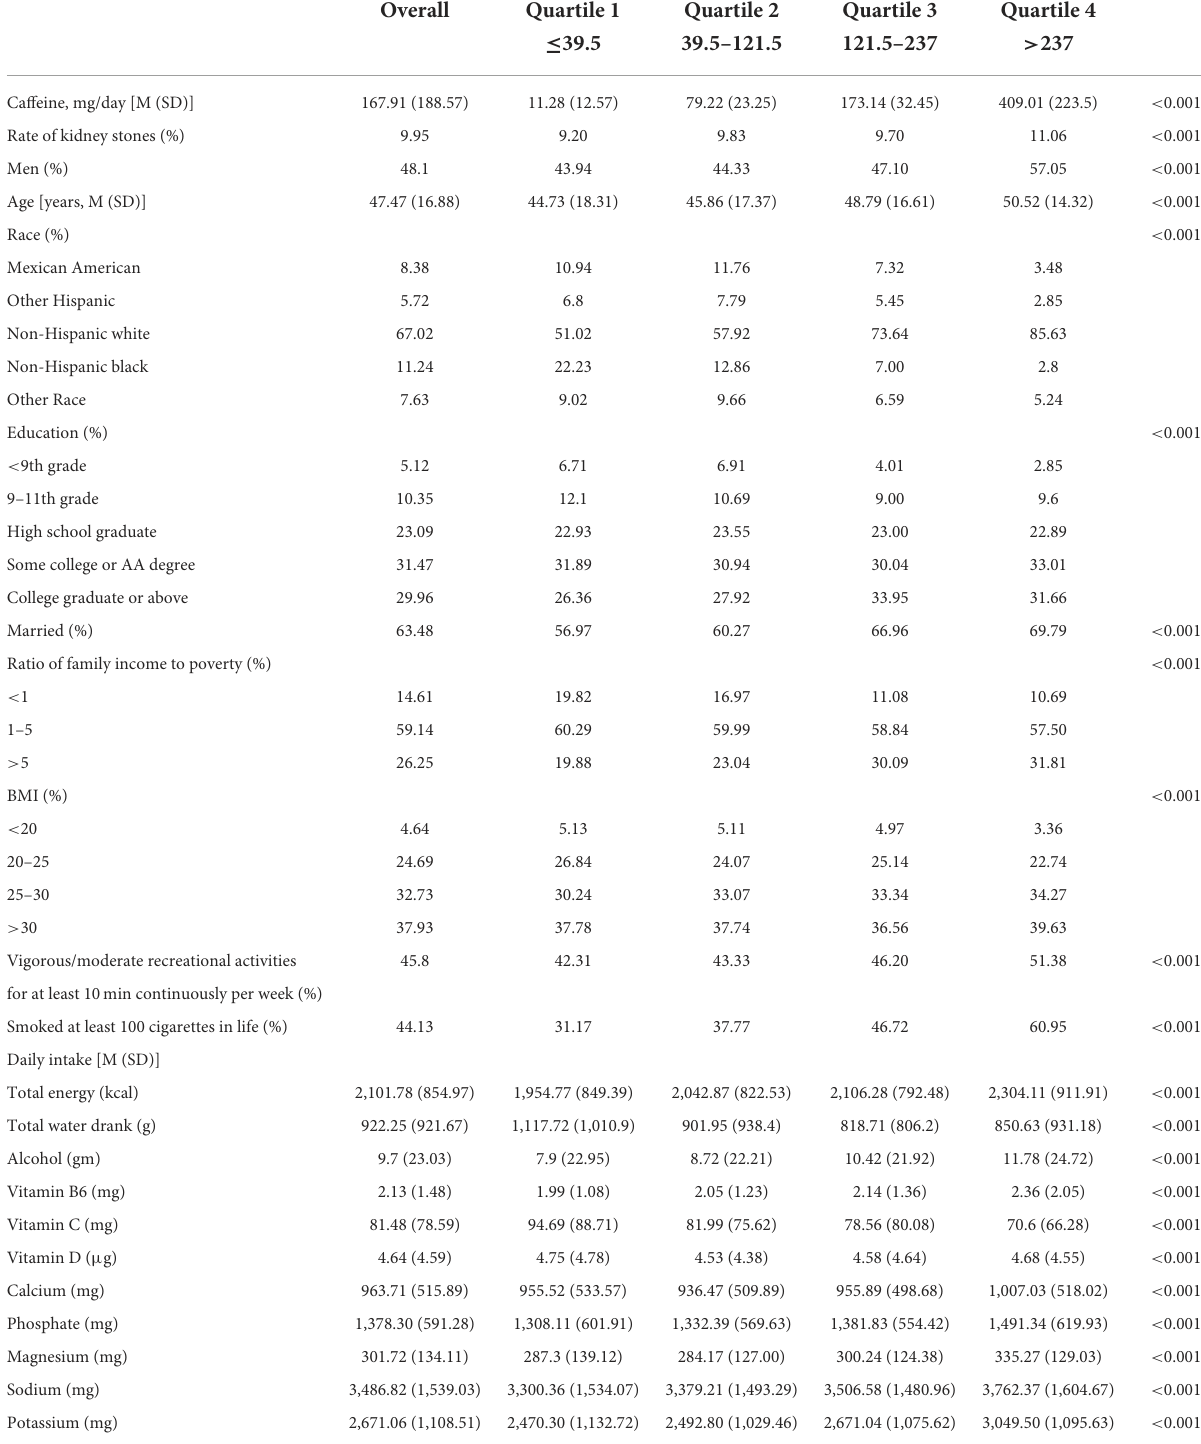
TABLE 1 Baseline characteristics of